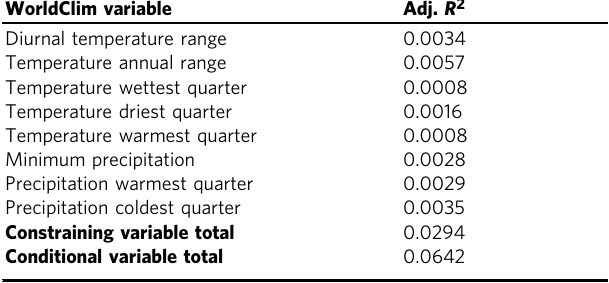
Table 1 Genetic variance across 22,006 genome-wide SNPs for 181 Junco individuals partitioned by eight WorldClim variables in a partial RDA (conditioned on background structure using the fi rst two axes of a